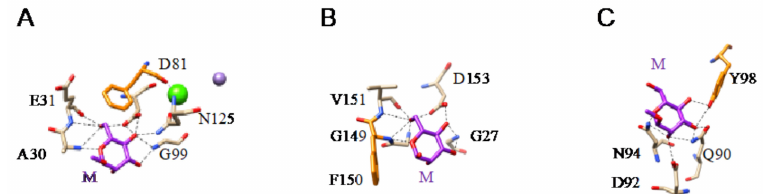
Figure 3. ( A ). Network of hydrogen bonds (black dashed lines) anchoring Man (M) to the amino acid residues A30, E31, D81, G99, and N135, forming the CBS of LoLI from Lathyrus ochrus (PDB code 1LOB). Aromatic residue F123 participating in stacking interaction with the pyranose ring of Man is colored orange. ( B ). Network of hydrogen bonds (black dashed lines) anchoring Man (M) to the amino acid residues G27, G149, V151, and D153, forming the CBS of Morniga-M from Morus nigra (PDB code 1XXR). Aromatic residue F150 involved in stacking interaction with the pyranose ring of Man is colored orange. ( C ). Network of hydrogen bonds (black dashed lines) anchoring Man (M) to the amino acid residues Q90, D92, and N94, forming the CBS of PCL from Polygonatum cyrtonema (PDB code 3A0D). Aromatic residue Y98 participating in stacking interaction with the pyranose ring of Man is colored